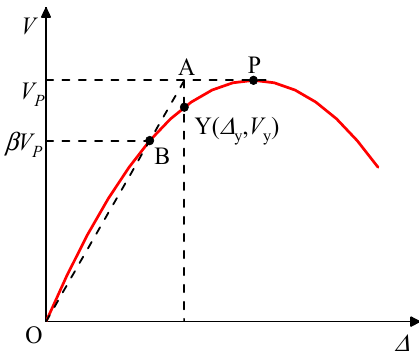
Figure 9. Park’s method for the yielding point. Table 4. Test results of all specimens.